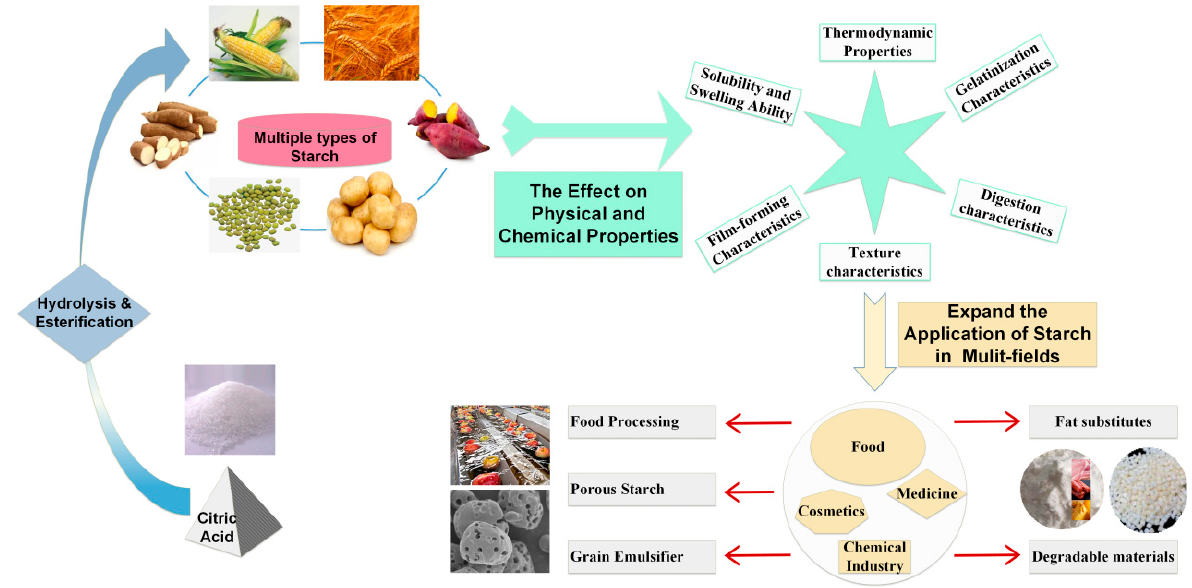
Figure 4. The effect of CA modification on the physical and chemical properties of starch and the application of CA-modified starch.